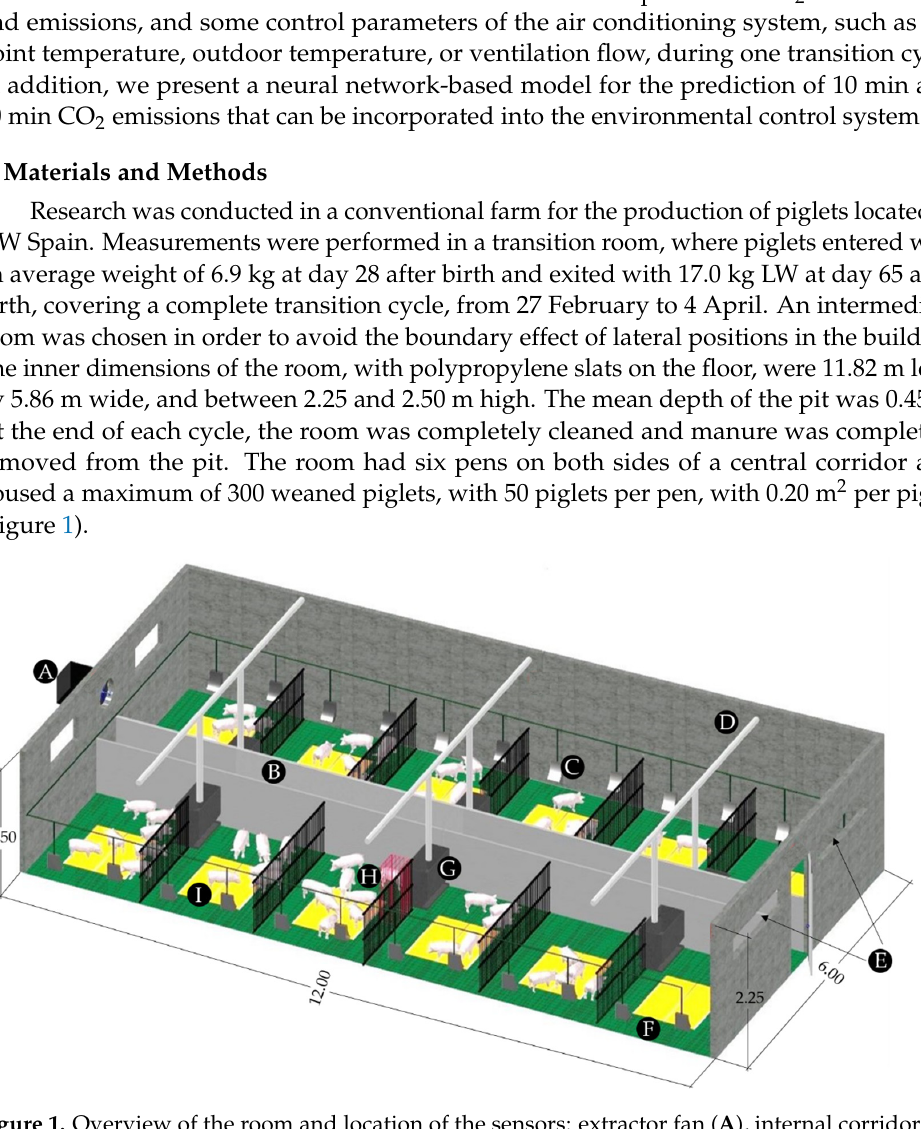
Figure 1. Overview of the room and location of the sensors: extractor fan ( A ), internal corridor ( B ), drinker ( C ), feed distributor ( D ), air inlet ( E ), slat ( F ), feeder ( G ), indoor sensor structure ( H ), and heating plate ( I ). The sensors for the speed of the air extracted through the ventilation system ( V m ) and CO 2 concentration at the ventilation air outlet ( C OUTLET ) were located at ( A ) and the sensor for CO 2 concentration in the exterior corridor of air inlet ( C INLET ) was located at ( E ).